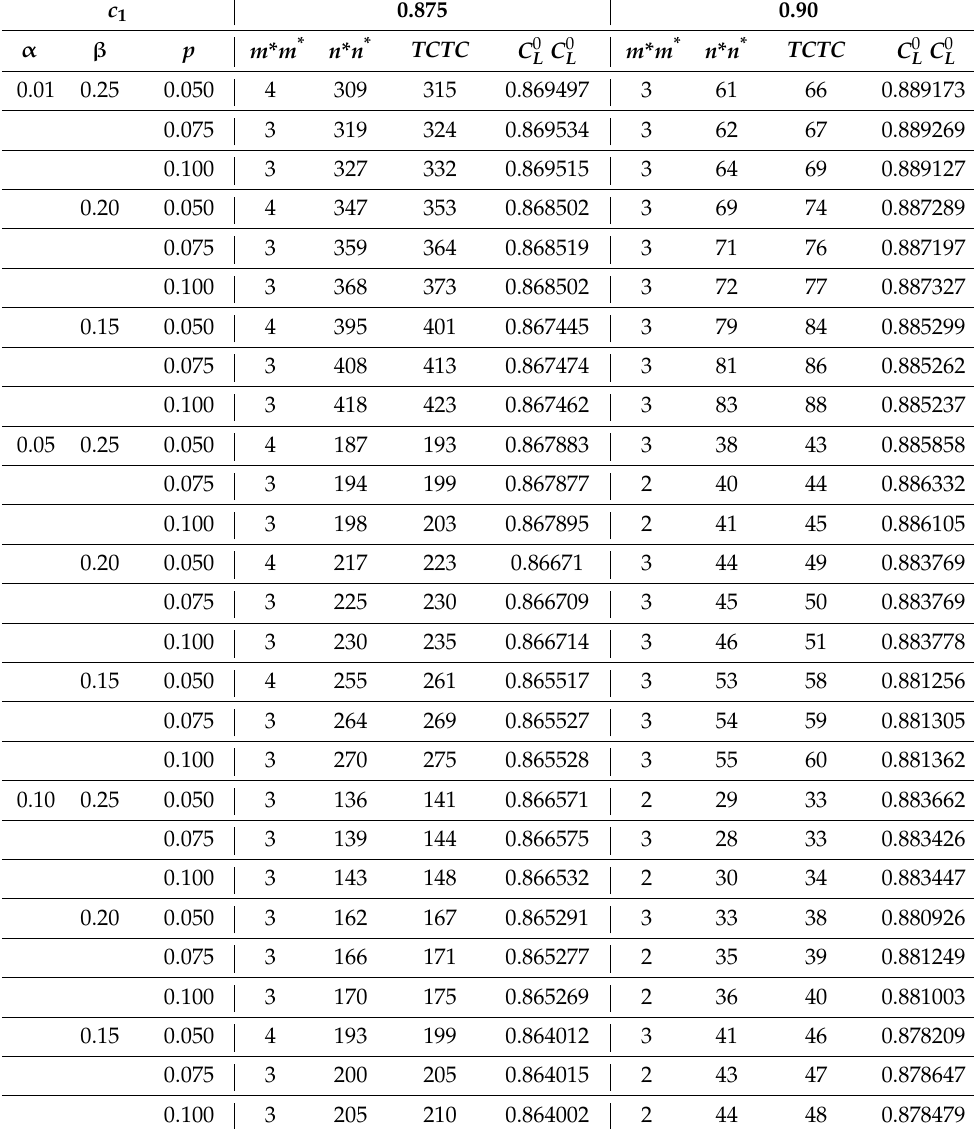
Table 1. The optimal ( m *, n *), total cost TC and critical value for c 1 = 0.875, 0.90, α = 0.01, 0.05, 0.1, β = 0.25, 0.20, 0.15 and p = 0.05, 0.075, 0.1 under m 0 = 20, L = 0.05 and c 0 = 0.85.